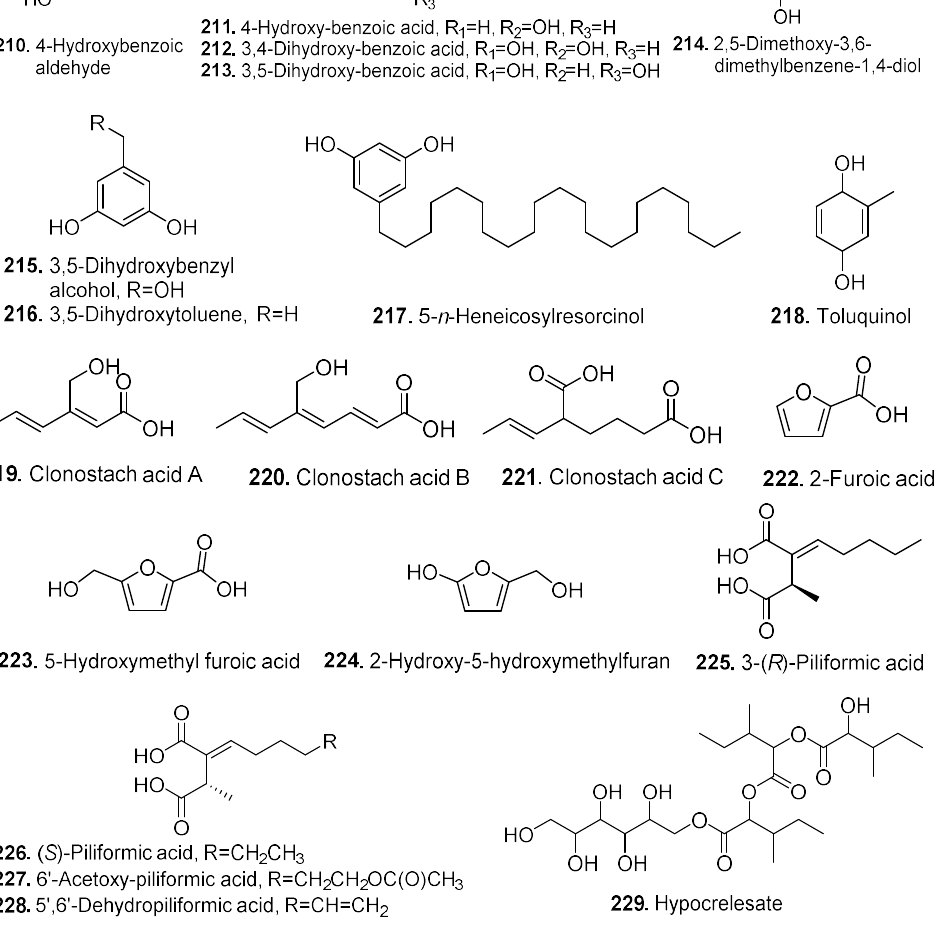
Figure 15. Miscellaneous metabolites isolated from Clonostachys fungi.